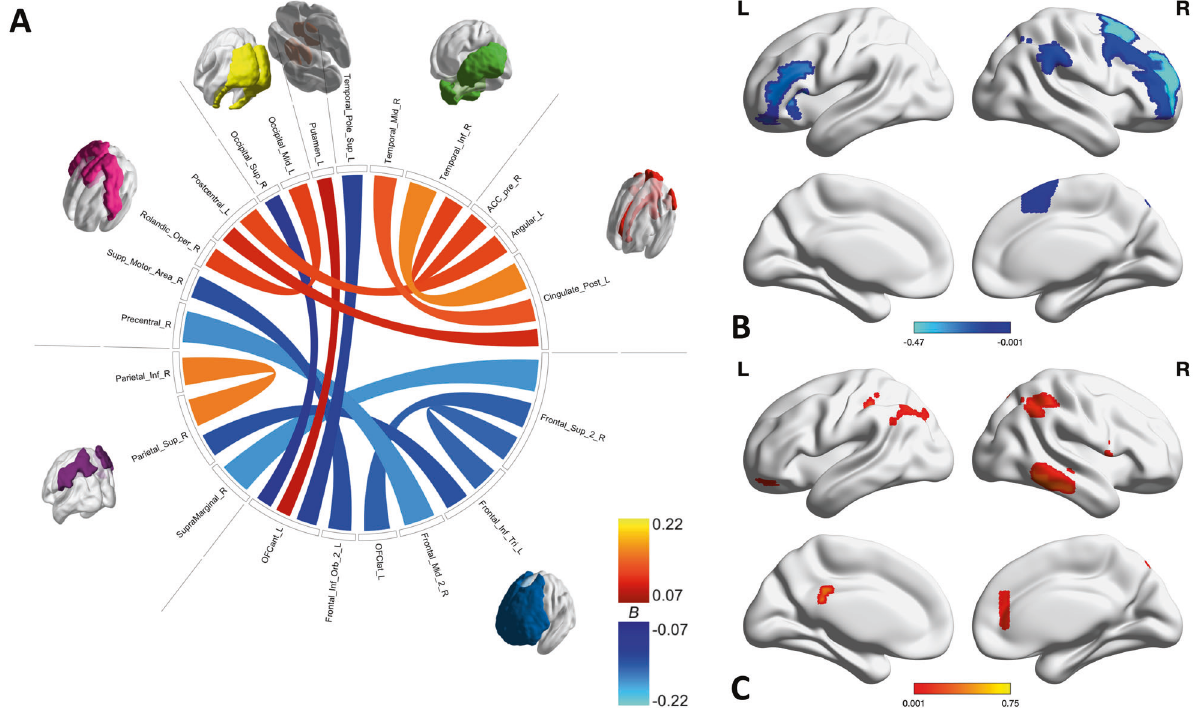
Fig. 3 Within LECN connectivities and regions associated with worry. A Chord diagram shows individual connections identi fi ed by HC with both weight and color indicating the strength of the association with worry severity. B , C Brain maps show the sum of the negative ( B ) and positive ( C ) associations with worry for each region. Negative associations with worry all involve the PFC while positive associations are focused in the left PCC and right temporal